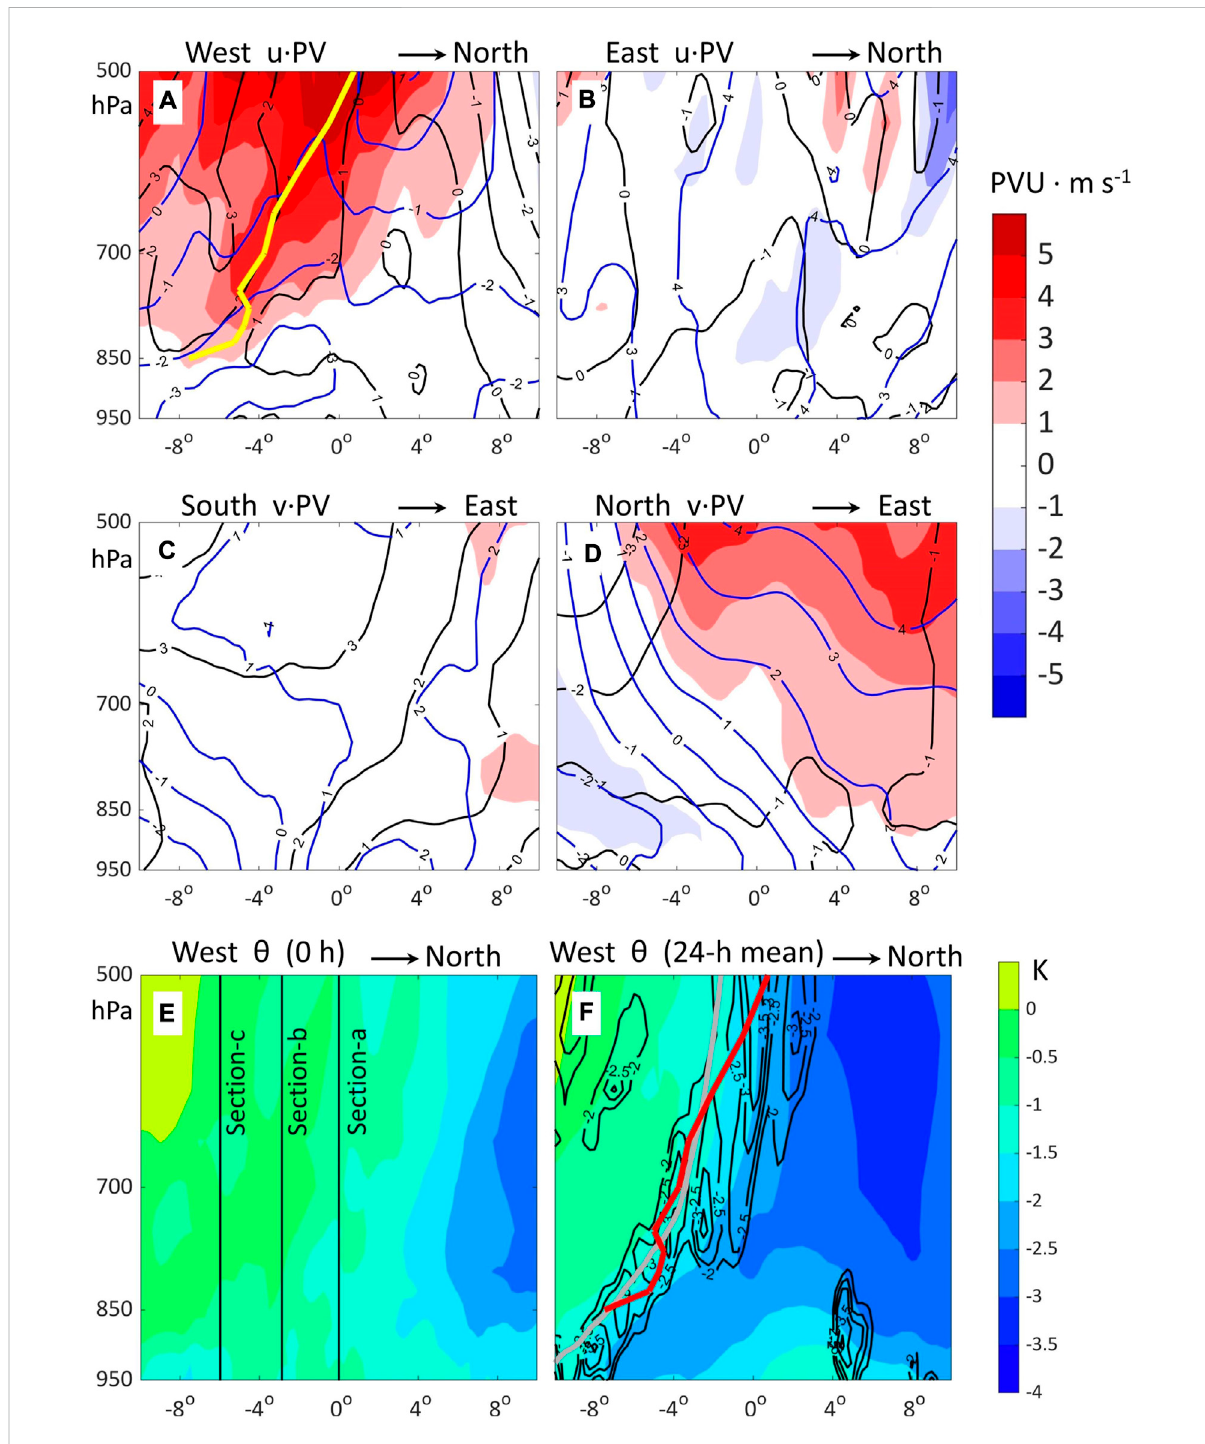
FIGURE 8 Difference in the24-h averaged wind speed and PV transport between ECs and OCs at thewest (A) , east (B) , south (C) , and north (D) boundary, as well as difference in thermal structures atthe west boundary atinitial time (E) and averaged during the fi rst 24 h (F) . In (A) and (B) , shadings denote the difference in the product of the zonal wind speed and PV, while in (C) and (D) , shadings denote the difference in the product of the meridional wind speed and PV. Black/blue contours denote the difference in the zonal/meridional wind speed (unit: m s − 1 ). In (E) and (F) , shadings denote potential temperature, and contours in (F) denote its meridional gradient (i.e., z θ z y ; unit: 10 − 6 K m − 1 ) with values > -2 not given; the difference to the north ofthethickgraylinein (F) haspassedthesigni fi cancetest( t -test)withacon fi denceof0.95.The thickyellowlinein (A) andredlinein (F) locate the maximum of uPV at each level. Black lines in (E) locate the three zonal cross-sections in Figure